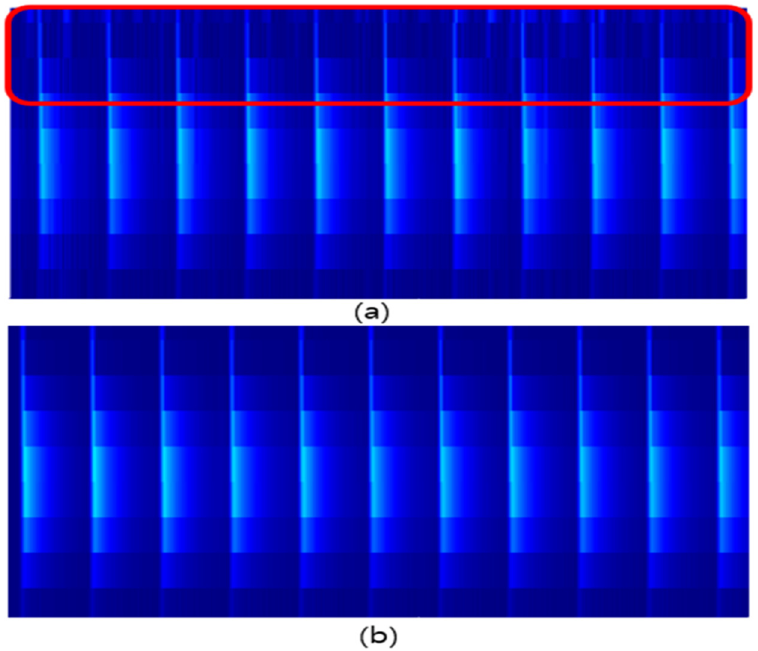
Figure 24. Difference between with noise signals and without noise signals in STFT [( a ): with noise, ( b ): without noise].